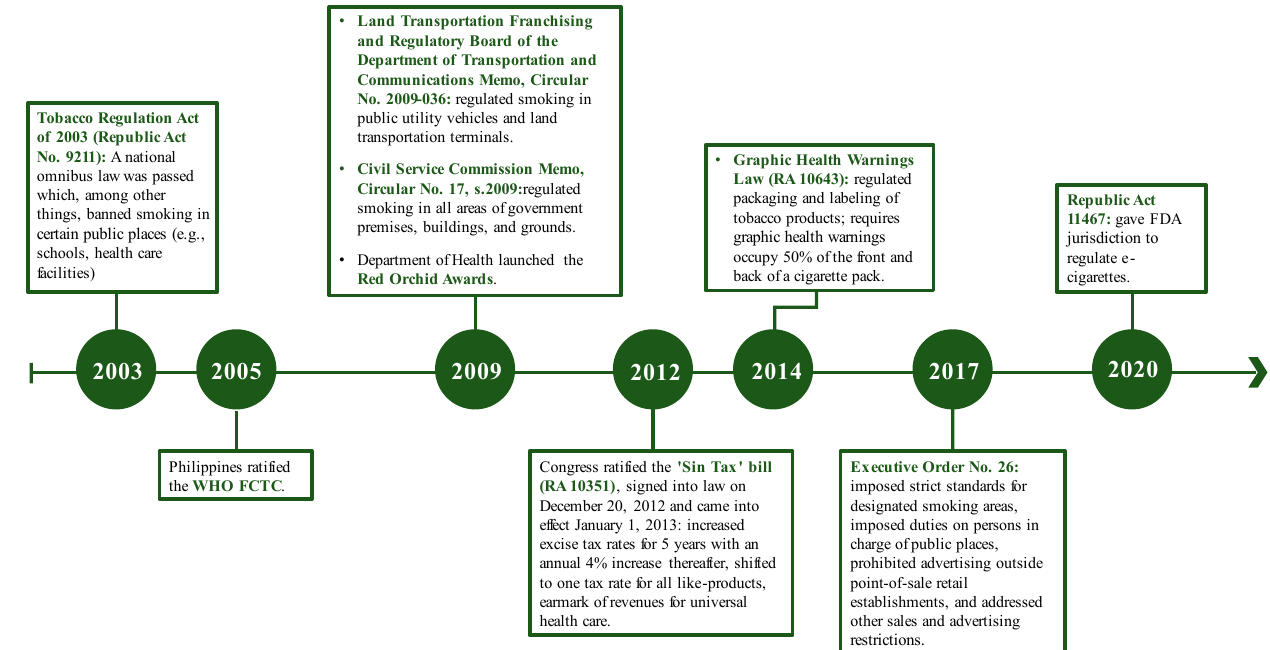
Figure 1. Timeline of selected tobacco control policies in the Philippines, 2003 – 2020 [11,12,15,16].